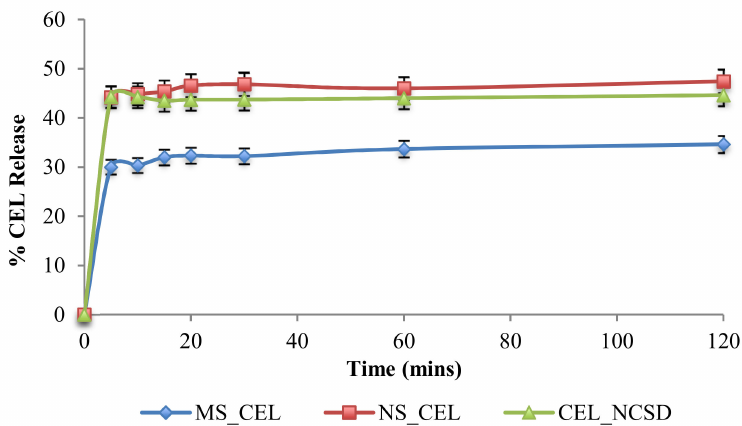
Figure 8. Percentage release profile of MS_CEL, NS_CEL and CEL_NCSD. The values are reported as Mean ±